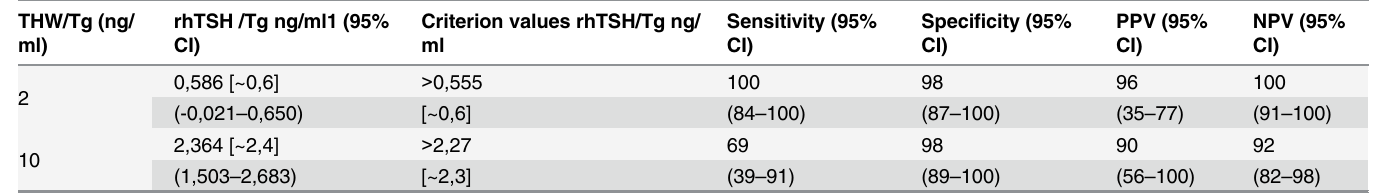
Table 3. Thyroid hormone withdrawal-stimulated thyroglobulin (THW/Tg) cut-off levels and corresponding recombinant human thyrotropin-stimu- lated thyroglobulin (rhTSH/Tg) cut-off levels in regression analysis and ROC analysis. THW/Tg (ng/ rhTSH /Tg ng/ml1 (95% ml)